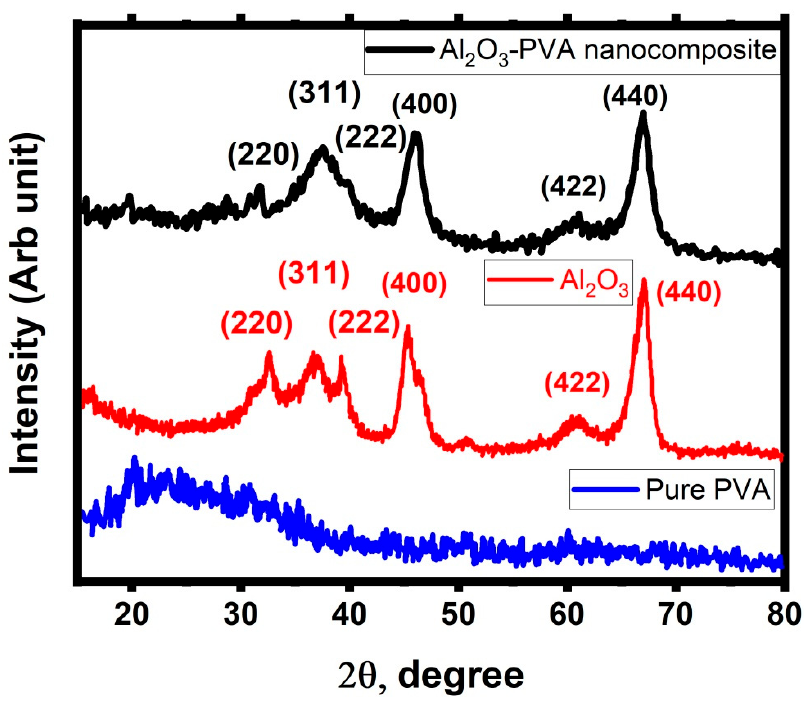
Figure 5. XRD diffractogram of PVA, Al 2 O 3 nanoparticles, and Al 2 O 3 /PVA